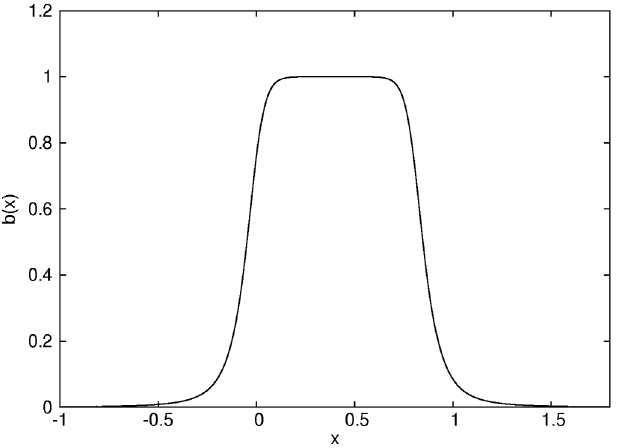
FIG. 5. Second derivative of the field profile for a dipole magnet with a ¼ 0 : 1 , b ¼ 0 : 4 , d=a ¼ 0 : 5 , and B 0 ¼ 1